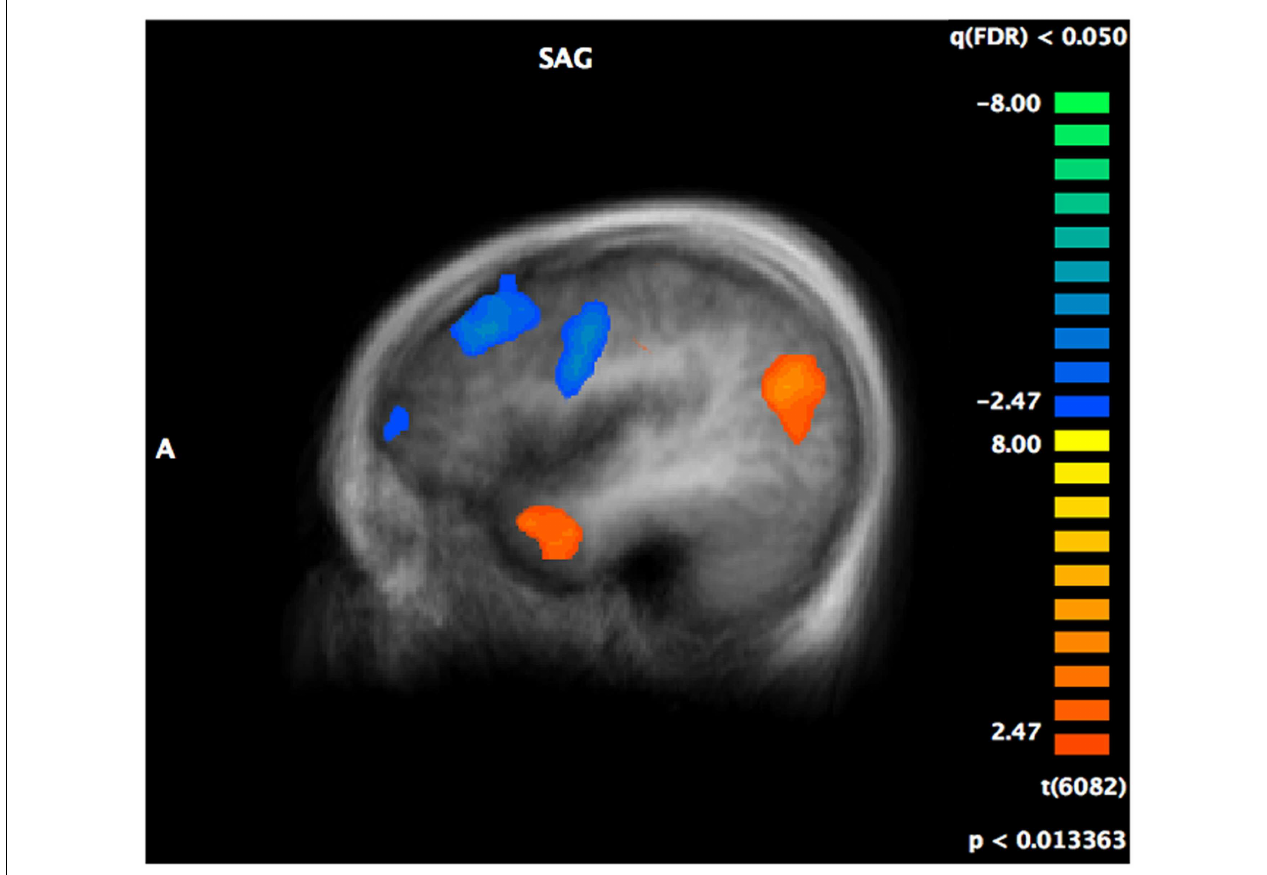
FIGURE 3 |A t-map showing regions of the brain activated more in controls (in blue) compared to regions activated more in individuals withASD (in red) during the crossmodal emotion matching. The activation differences are visible from x =− 43 (left